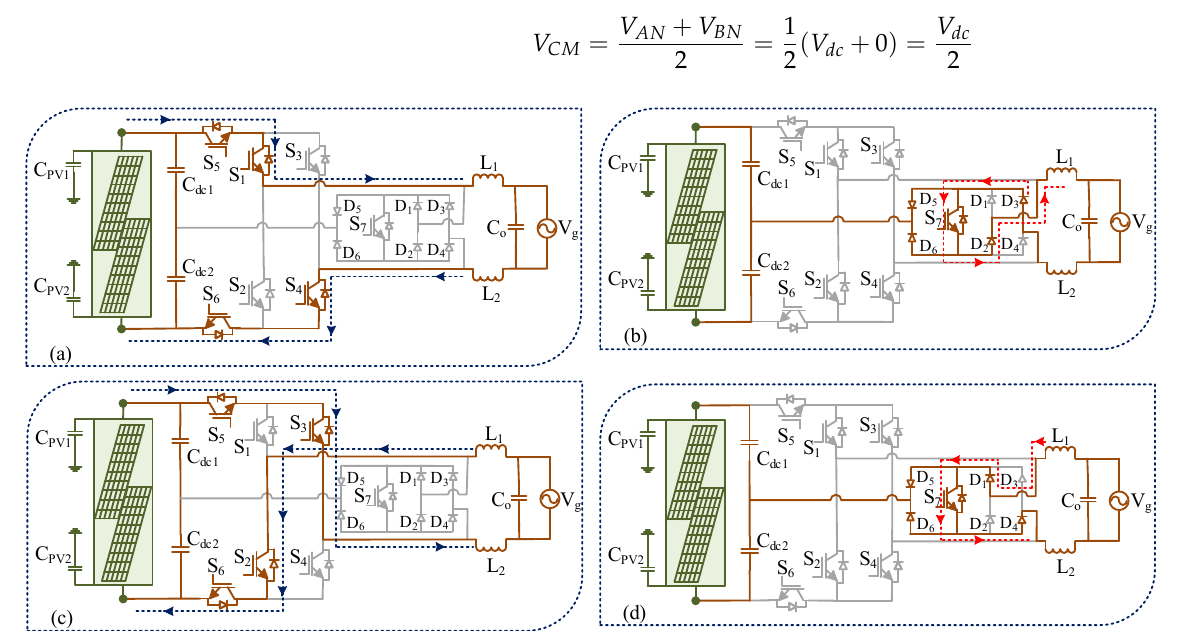
Figure 7. Conduction modes under unity power factor: ( a ) positive half-cycle active mode, ( b ) positive half-cycle freewheeling mode, ( c ) negative half-cycle active mode, and ( d ) negative half-cycle freewheeling mode.